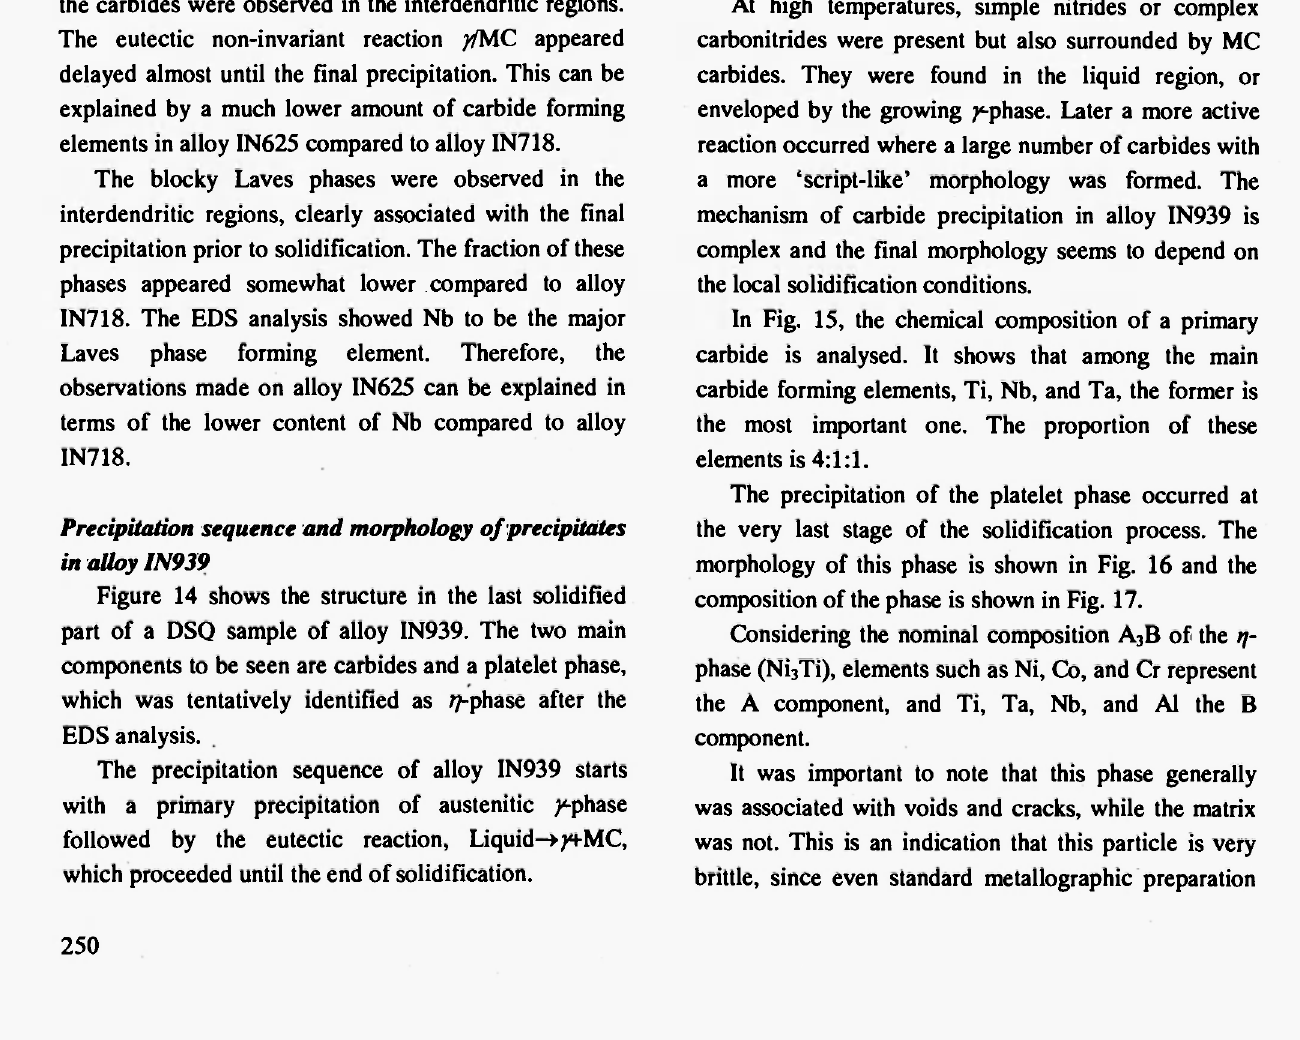
Fig. 13: IN625. As-solidified microstructure with eutectic carbides and Laves